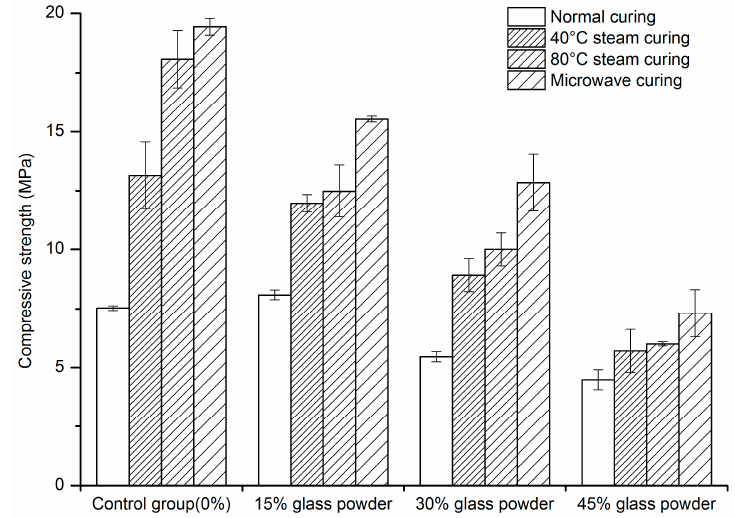
Figure 1. Compressive strength of mortar at one day.